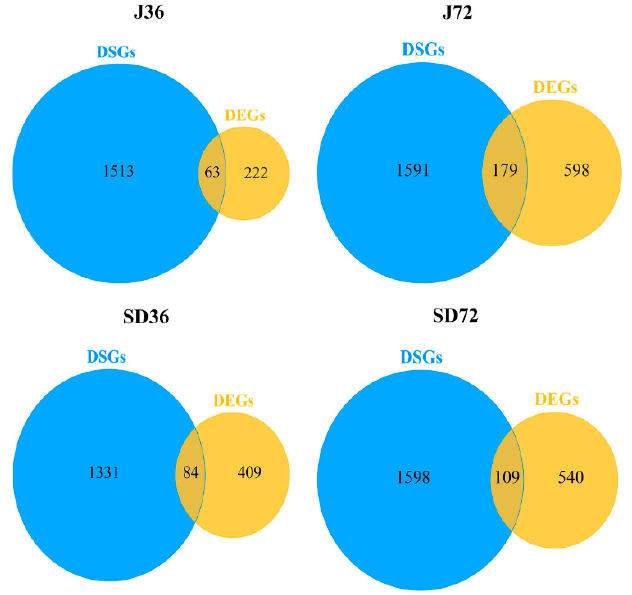
Figure 8. Clustering of DSGs and DEGs in response to A. alternata AP infection in apple. Venn diagram showing that the overlap of DSGs and DEGs in J36, J72, SD36 and SD72 groups. Genes with DAS events and FDR < 0.05 were identified as DSGs. Genes with |log 2 FC| ≥ 1 and FDR < 0.01 were identified as DEGs.